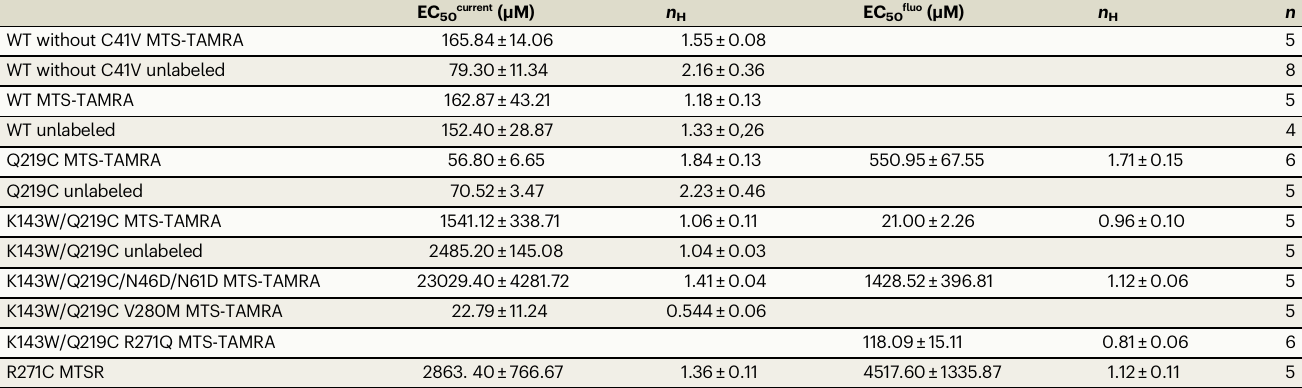
Table 1 | EC 50 values for current and fl uorescence responses to glycine at labeled and unlabeled C41V-GlyR α 1 mutants EC 50 current (µM) n H EC 50 fl uo (µM) n H n WT without C41V